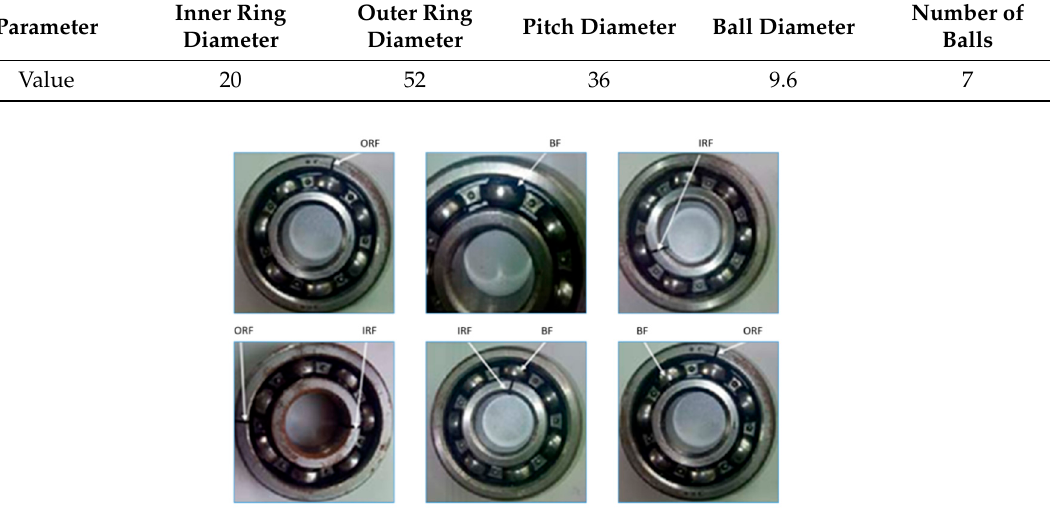
Table 6. HRB6304 bearing parameters (mm).